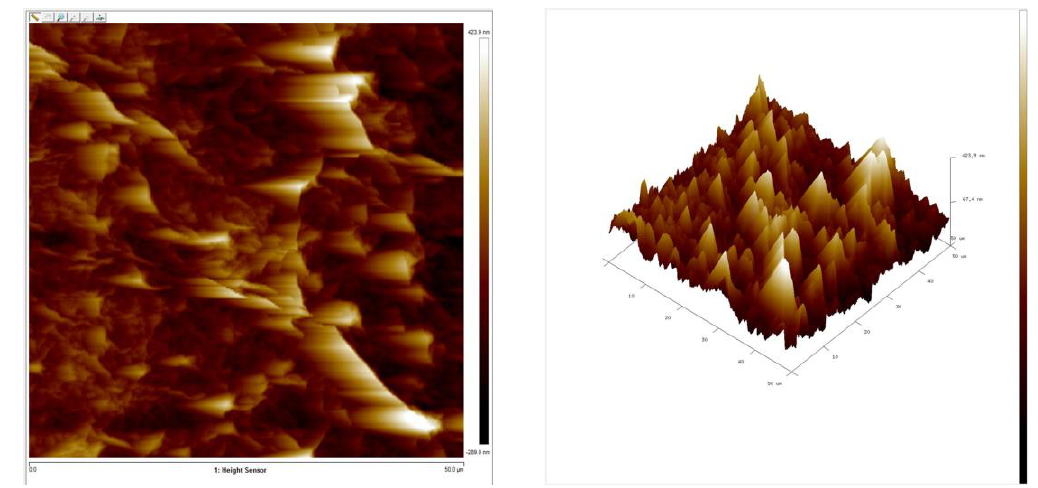
Figure 6. 2D and 3D atomic force microscope (AFM) images of GO membrane.